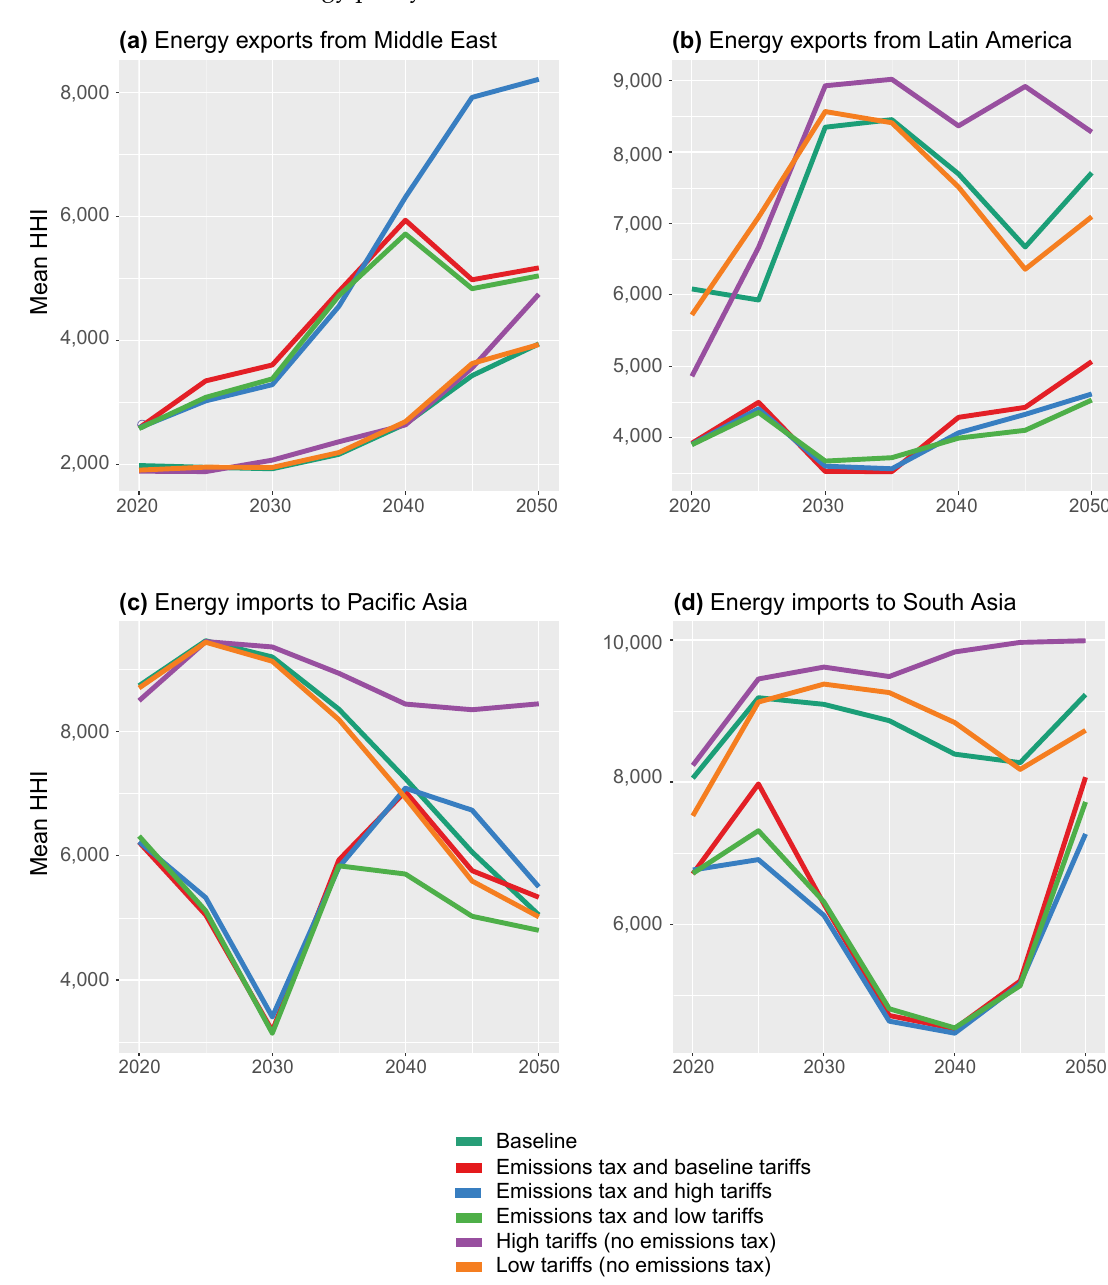
Figure 7. Energy security based on mean Herfindahl–Hirschman Index ( HHI ) values for major importers and exporters (the lower the index, the higher energy security and diversity). The figure presents the top two energy-exporting regions ( a , b ) and top two energy-importing regions ( c , d ). Lines are colored by scenario.